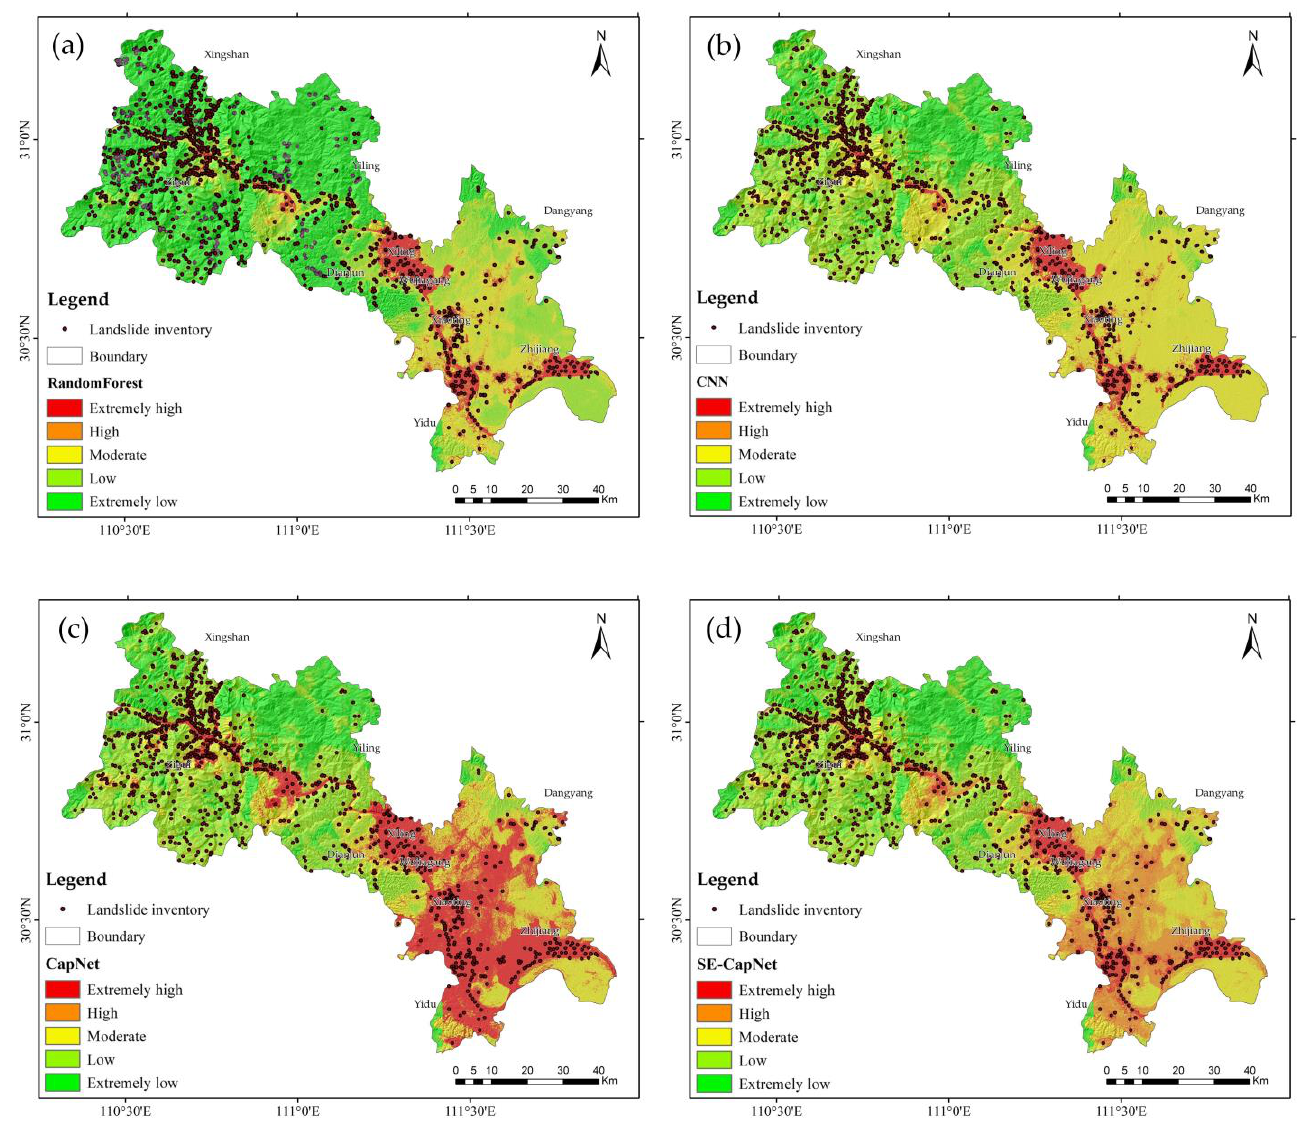
Figure 11. LSE Based on various methods. ( a ) RF based LSE result; ( b ) CNN based LSE result; ( c